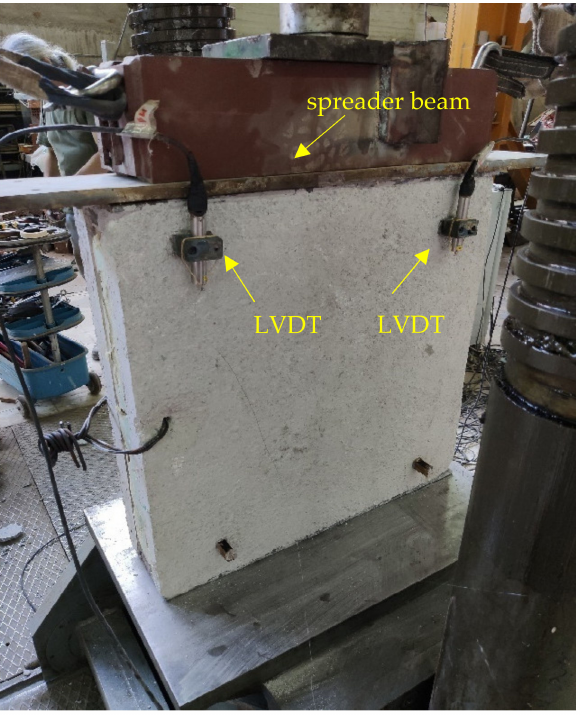
Figure 6. Experimental setup of concentric axial compression on PCSP-2